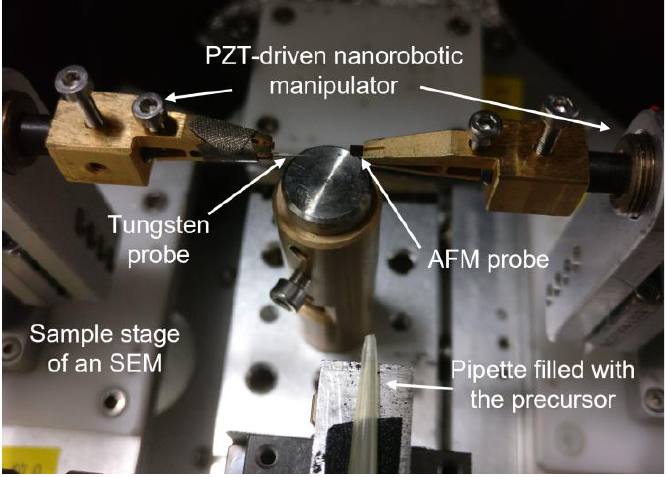
Figure 1. A schematic diagram of the in situ field emission platform we built inside an SEM, with two PZT-driven NRMs in it. two PZT-driven NRMs in